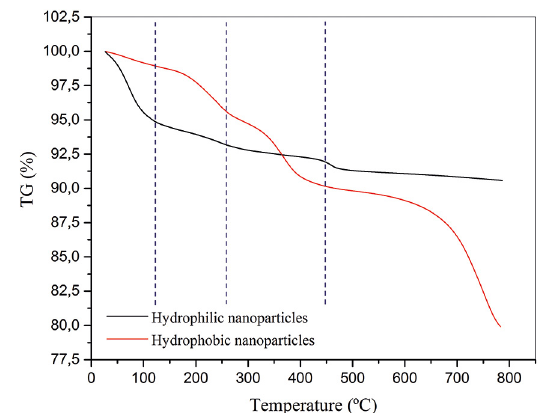
Figure 6. Adsorption of oleic acid on the surface of an iron oxide nanoparticle.